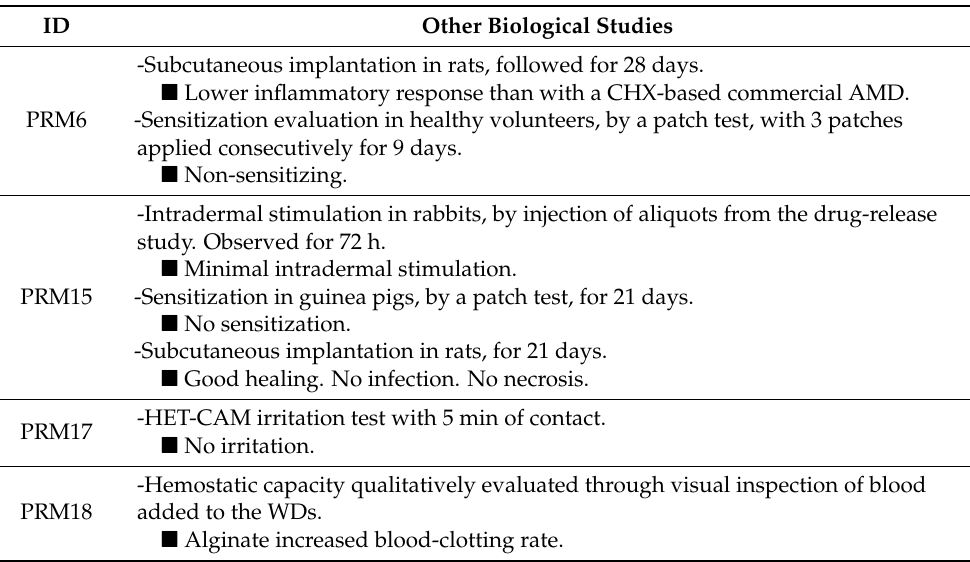
Table 10. Additional biological effects evaluated with PHMB-releasing membranes (PRMs) developed for antimicrobial dressings (AMDs). Membrane IDs and corresponding bibliographic references are the same as in Table